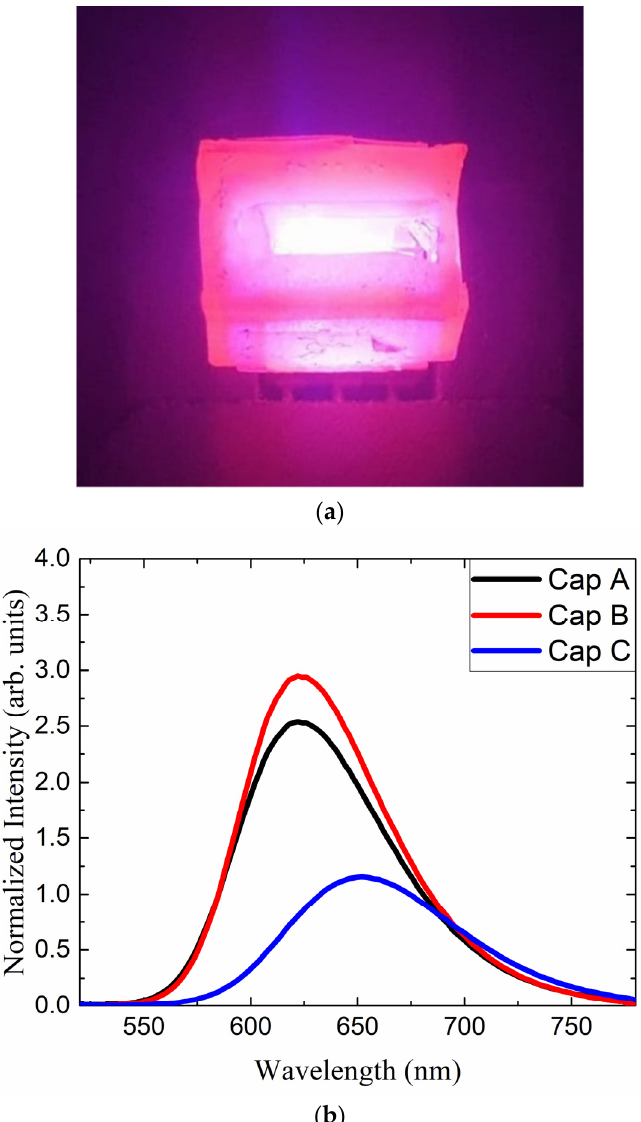
Figure 2. The photo of the emitting red QD combined with blue LED chips ( a ) and the photolumi- nescence emitting spectra of three kinds of red QD caps excited by blue LEDs at ~453 nm ( b ). These QD caps were combined with a commercially available 6-inch, 15-W white LED lighting (KE15DN61S57A1, Partner Co., Gimpo, Korea). It consists of 72 white LEDs